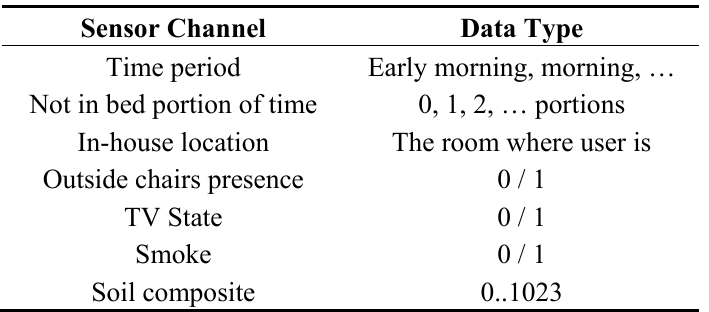
Table 1. The sensor channels training